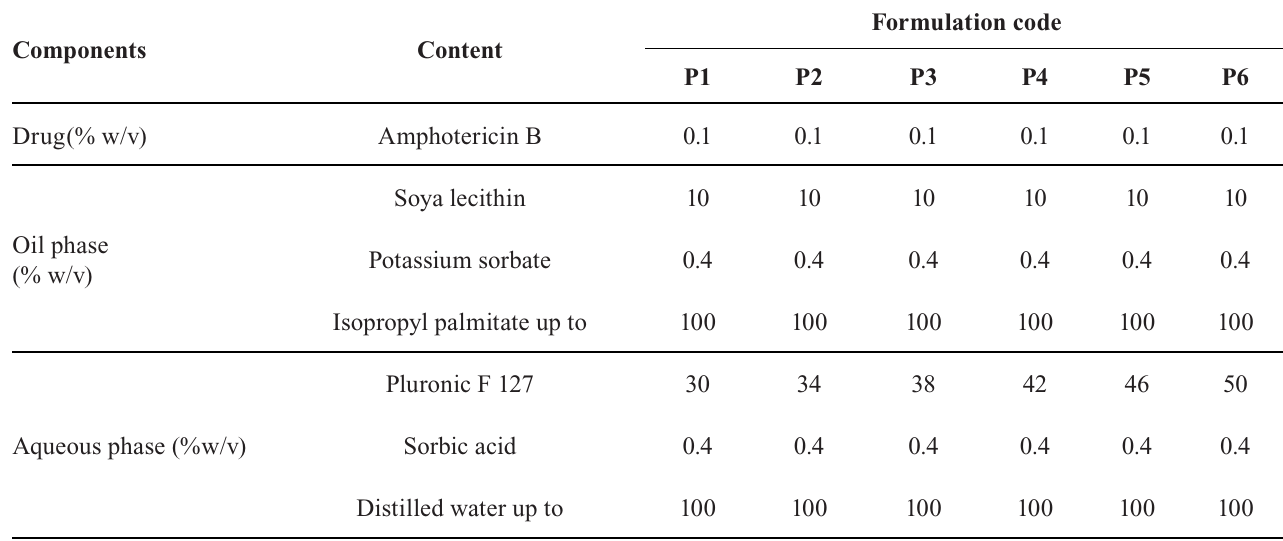
TABLE II - Formulation of pluronic lecithin organogel from P1 to P6